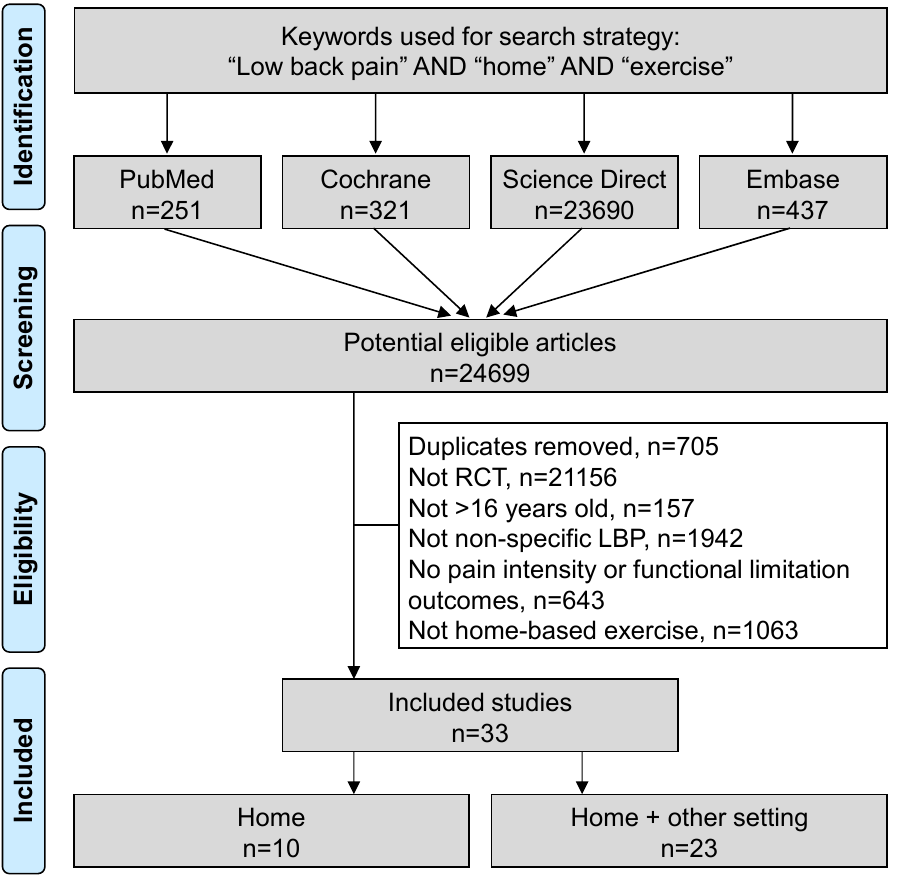
Figure 1. Flow Figure 1. Flow chart.